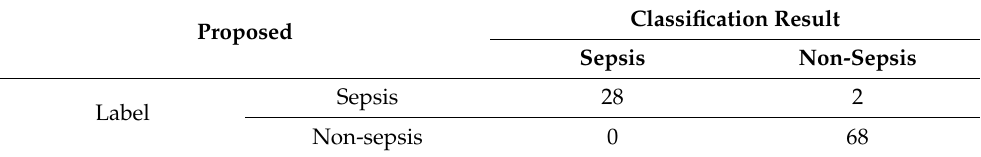
Table 2. Confusion matrix of our method. Classification accuracy achieved about 98.0%